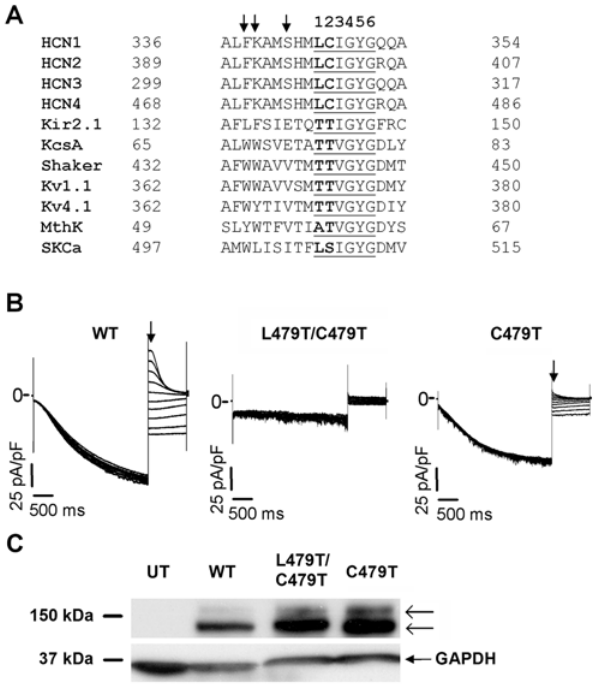
Figure 1. Ion selectivity in WT and C479T HCN4 channels. (A) Sequence alignment of mammalian HCN channels, and various K + selective channels shows all mammalian HCN channels have a leucine and cysteine residue in place of the two threonines typically (though not always) present in the underlined K + channel ‘selectivity sequence’. These residues (L478 and C479 in HCN4) were mutated to threonine to create a pore-lining sequence resembling that of a K + selective channel. (B) Sample traces of WT, L478/C479T, and C479T HCN4 currents recorded in a 5 mM K + /135 mM Na + bath solution, elicited by a 3 s prepulse to 2 130 mV from a holding potential of 0 mV, followed by a 1 s test pulse between + 20 to 2 70 mV ( D V=10 mV). (C) Western blots performed from whole-cell lysates of untransfected (UT) CHO-K1 cells, or cells transfected with WT, L478/C479T or C479T constructs, with GAPDH used as a loading control. WT and mutant channels are highly expressed in both N -glycosylated and core bands ( r ), indicating the absence of L478/C479T currents in expressed cells is not due to mis- trafficking or low protein production.